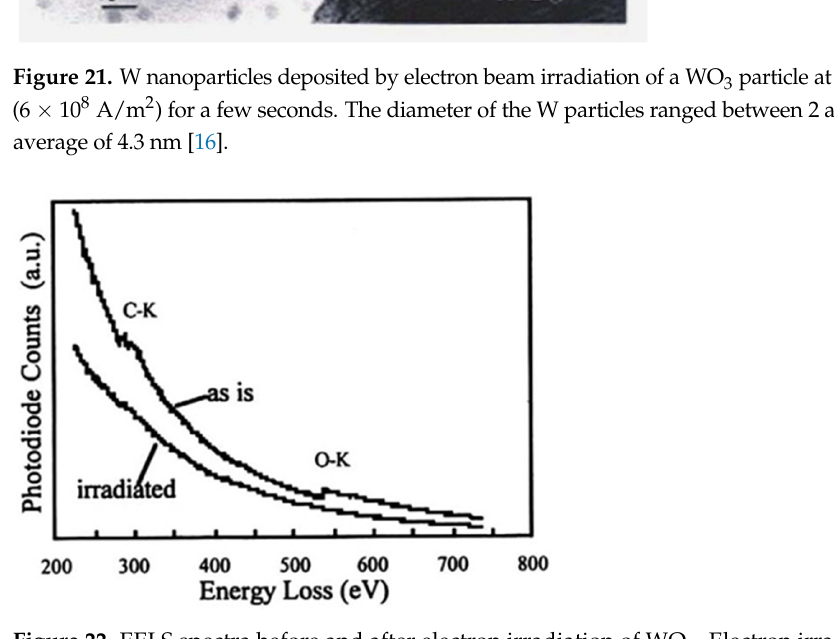
Figure 22. EELS spectra before and after electron irradiation of WO 3 . Electron irradiation induced the disappearance of the O-Kα peak to form pure W nanoparticles [16].